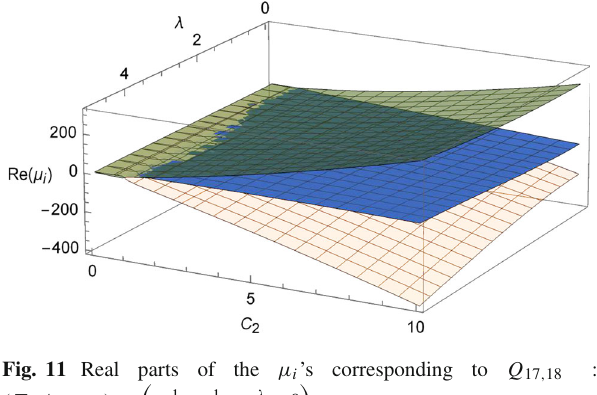
Fig. 11 Real parts of the μ i ’s corresponding to Q 17 , 18